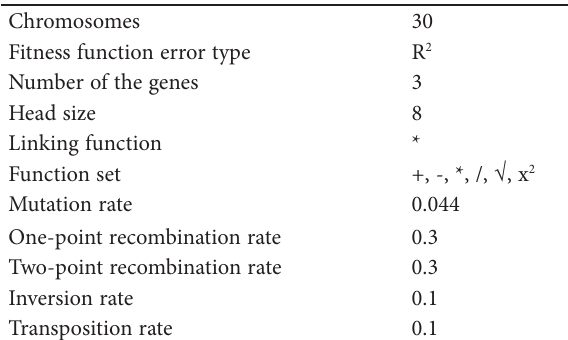
Table 2. Parameters of the GEP